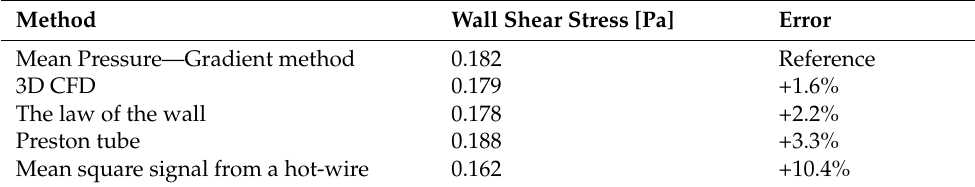
Table 6. Comparison of the experimental and computational methods for the calculation of wall shear